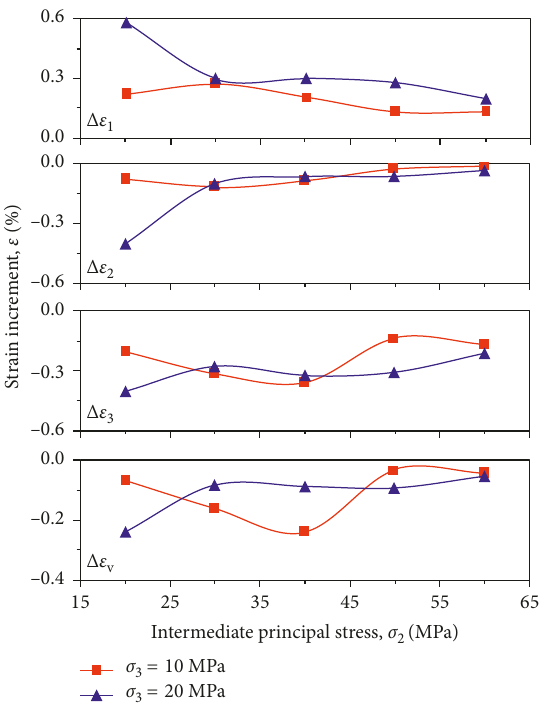
Figure 13: Variation in strain increment of rock in the unstable crack growth stage under true triaxial compression.